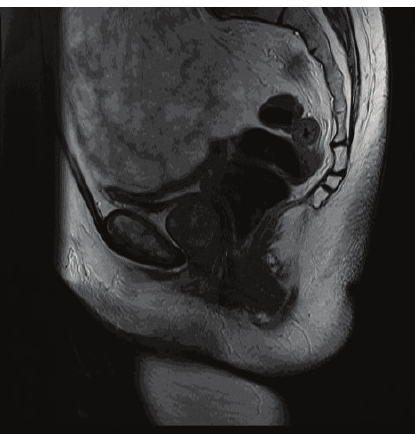
Figure 1: MRI of paraurethral leiomyoma in relation to urethra.